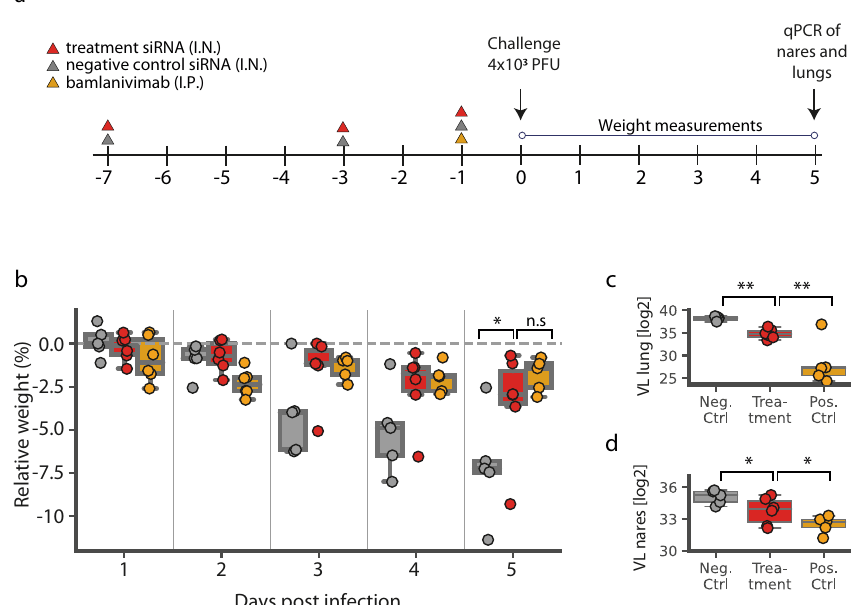
Fig. 5 Prophylactic treatment against SARS-CoV-2 infection in Syrian hamsters. a Dosing regimen. Syrian hamsters ( n = 6, per group) pre-treated with a non-targeting siRNA (negative control, grey), the LY-CoV555 antibody (positive control, yellow) or our lead siRNA cocktail (treatment, red) were infected with 4 × 10 3 PFUs of the ancestral SARS-CoV-2 strain; b Weight change post infection. Box plot of the change in weight by treatment group relative to time postinfection; c , d Viral load at day 5 postinfection. All measurements were based on qPCR of the RdRP gene fi ve days postinfection from homogenised lungs c and nares d . In all panels p value is presented as: *<0.05,**<0.001. Ctrl: control; VL: viral load; Neg.: negative; Pos.: positive; tment: treatment; n.s.: not signi fi cant. In panels b – d , horizontal lines represent the median, box edges represent the 25% and 75% quartiles, and the whiskers represent the furthest data points within up to 50% of the interquartile range. P-values were computed using parametric bootstrap